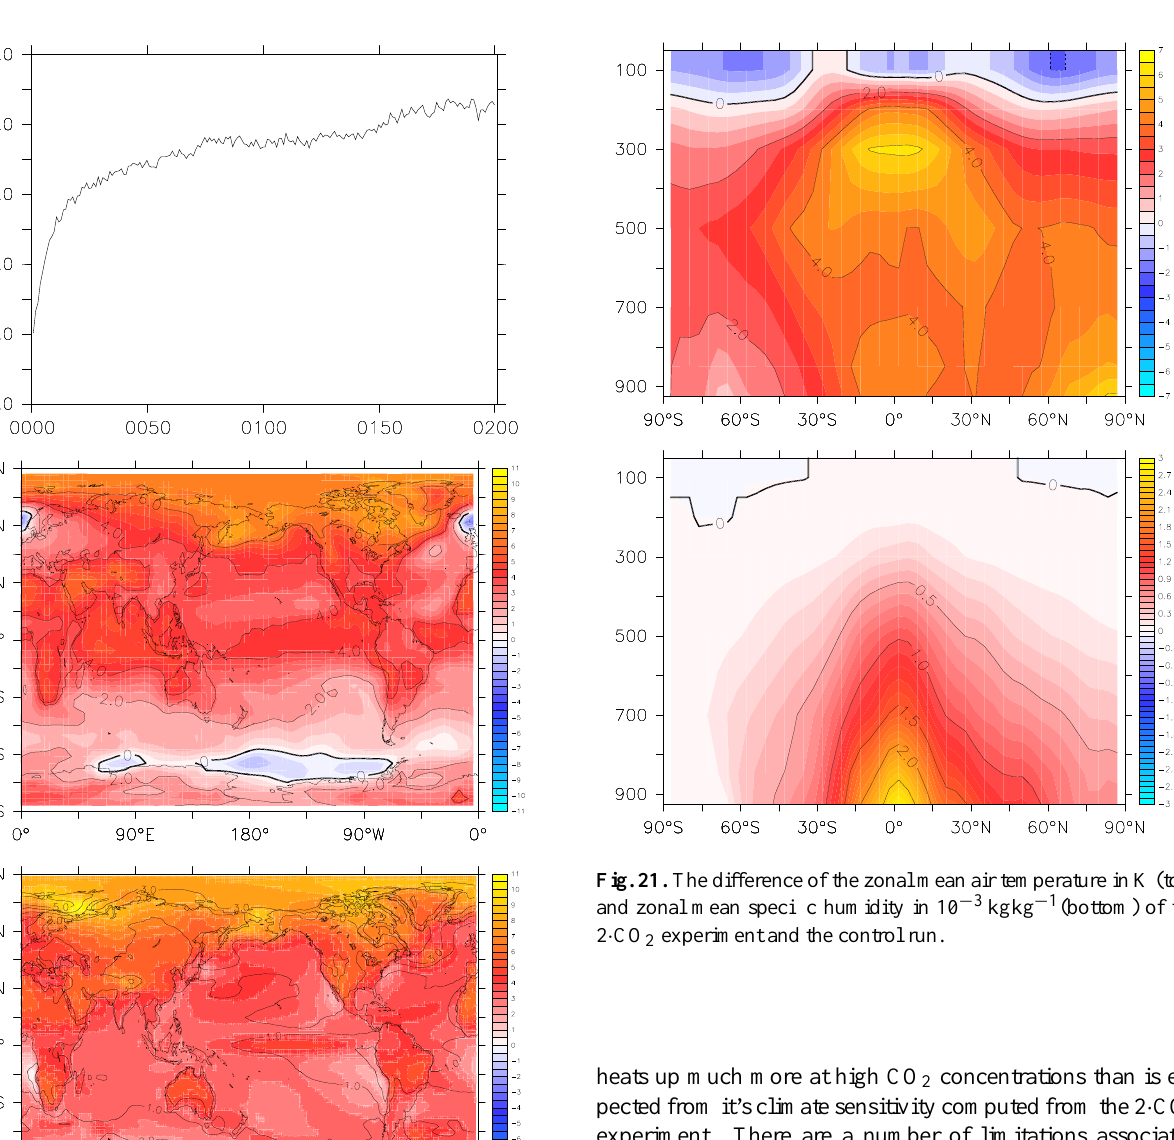
Fig. 22. The difference of the Atlantic meridional overturning stream function between the 2 × CO 2 experiment and the control run (top) and the time series of the maximum AMOC strength in the 2 × CO 2 experiment (bottom), both in Sv .